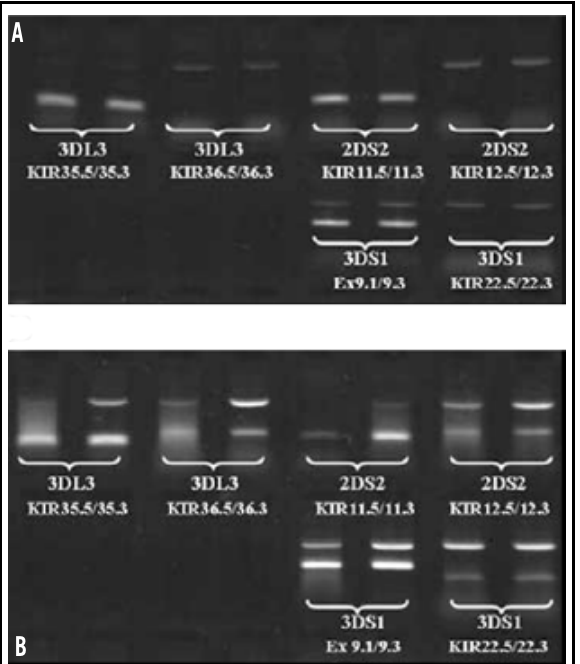
Figura 4 – Padrão das bandas obtidas para 2DS2 (KIR12.5/12.3), 3DL3 (KIR36.5/36.6) e 3DS1 (KIR22.5/22.3) com MgCl (b) . 2DS2 (KIR11.5/11.3), 3DL3 (KIR35.5/35.6) e 3DS1 (Ex9.1/9.3) atuaram como controles